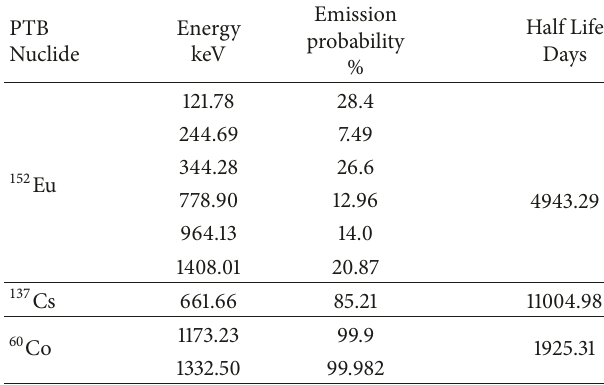
Table 2: Specifications of the radionuclides. PTB Nuclide